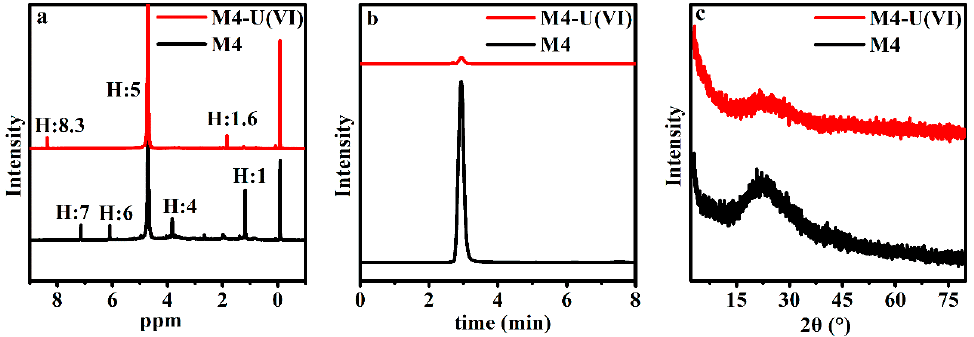
Figure 6. NMR ( a ), HPLC ( b ), and XRD ( c ) of the biomass of Deinococcus radiodurans of M4 (phos- phate esterification) before and after biosorption of uranium.